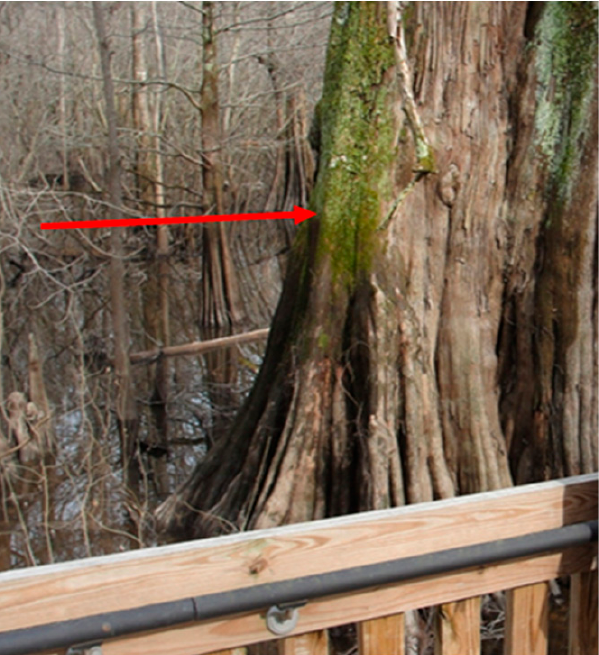
Figure 2. Sky Lake Wildlife Management Area. The large cypress tree in the foreground is several hundred years old. The arrow indicates a recent water level, demonstrating seasonal water level fluctuations of several meters in the